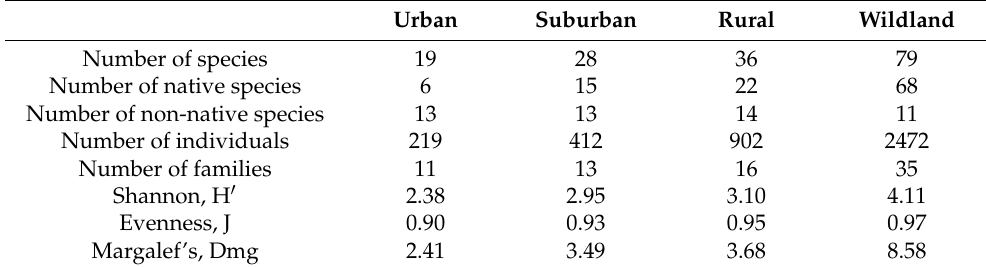
Table 2. Diversity indices in urban, suburban, rural, and wildland areas in Ipoh, Perak, Malaysia. See Table S1 for details on the native and non-native species. Urban Suburban Rural